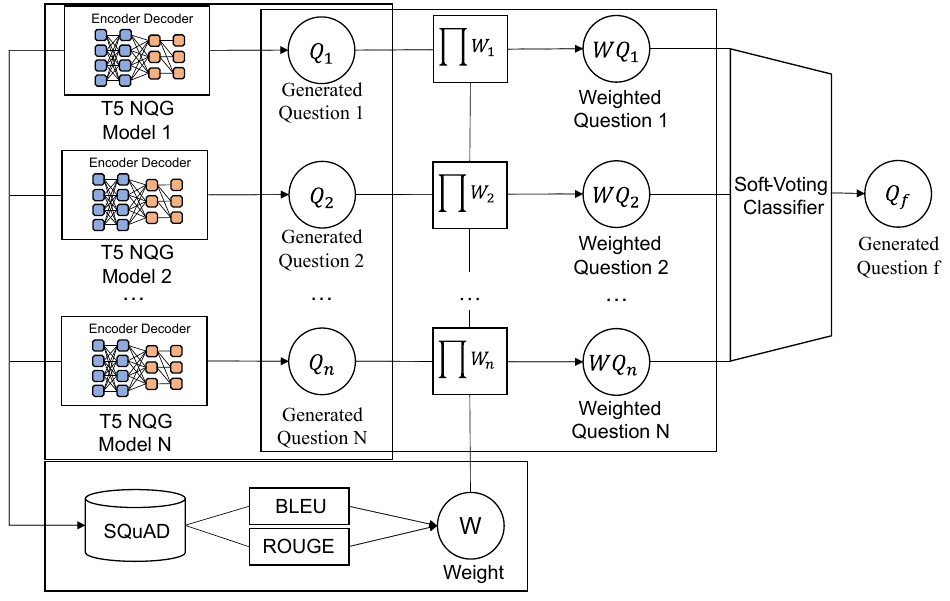
Figure 2. Architecture of